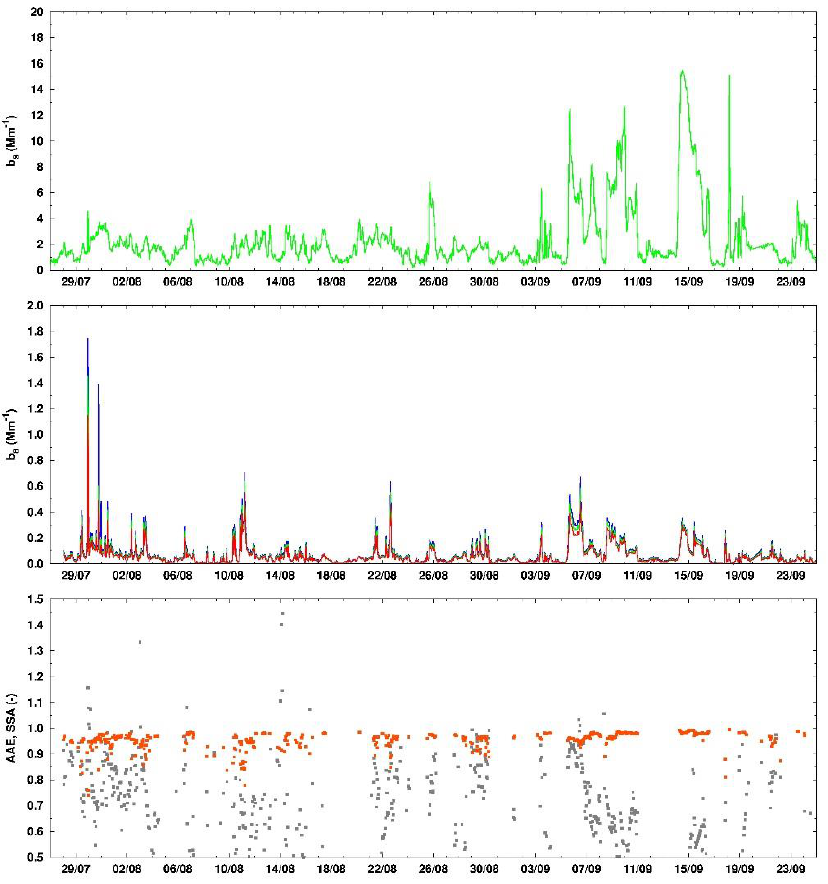
Figure 6. Hourly values of scattering (upper panel) and absorption (middle panel, blue = 440 nm, green = 530 nm, red = 660 nm) coefficients measured between 27 July and 24 September 2017 at the Gruvebadet laboratory (Ny-Ålesund) from Nephelometer M903 and PSAP. The bottom panel shows Ångström absorption exponent (AAE) (green) and SSA (red) values obtained for b a greater than 0.05 Mm –1 .